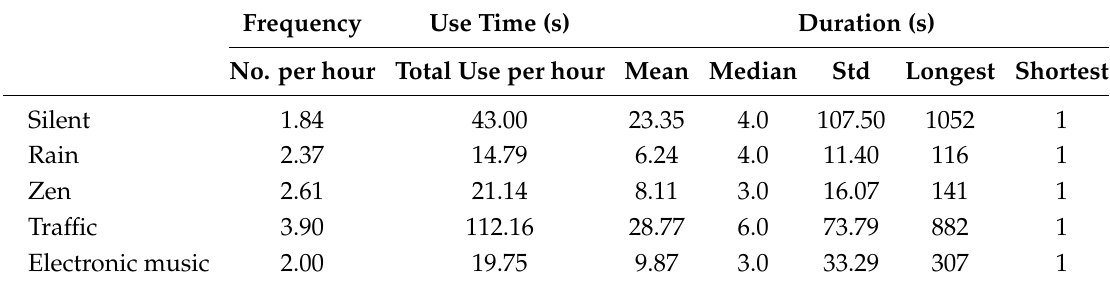
Table 4. Use time, duration, and frequency of interactions the sakis had with the audio enrichment device playing different sounds. Results reported in seconds (s) or interaction numbers.